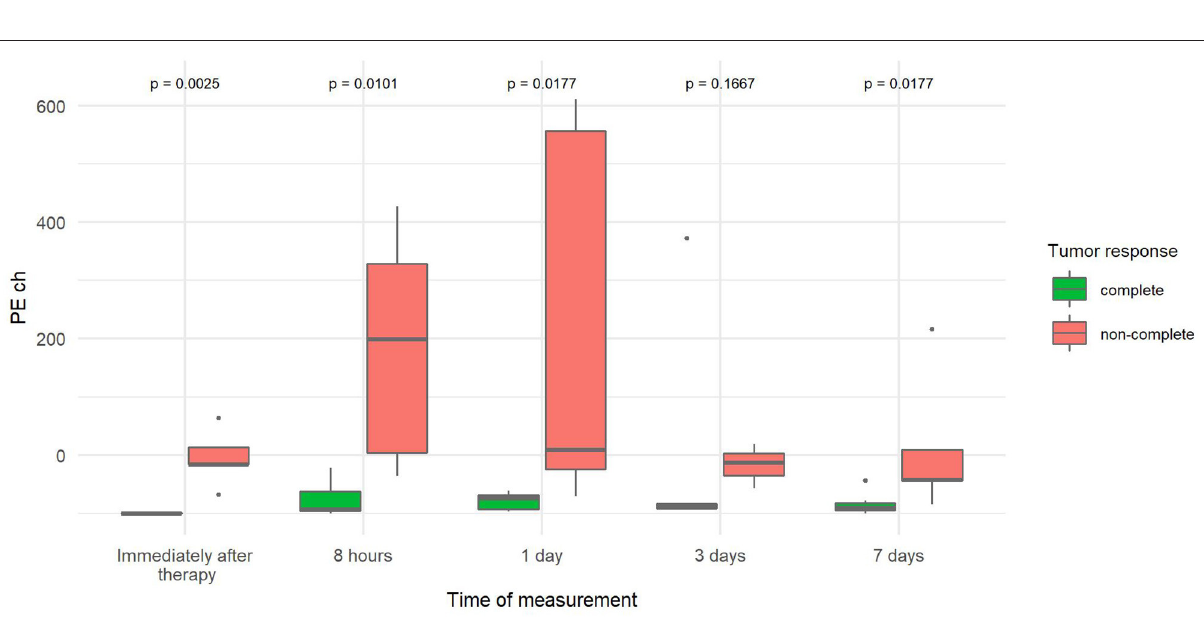
induce a “vascular disrupting effect,” i.e., cytotoxic effect